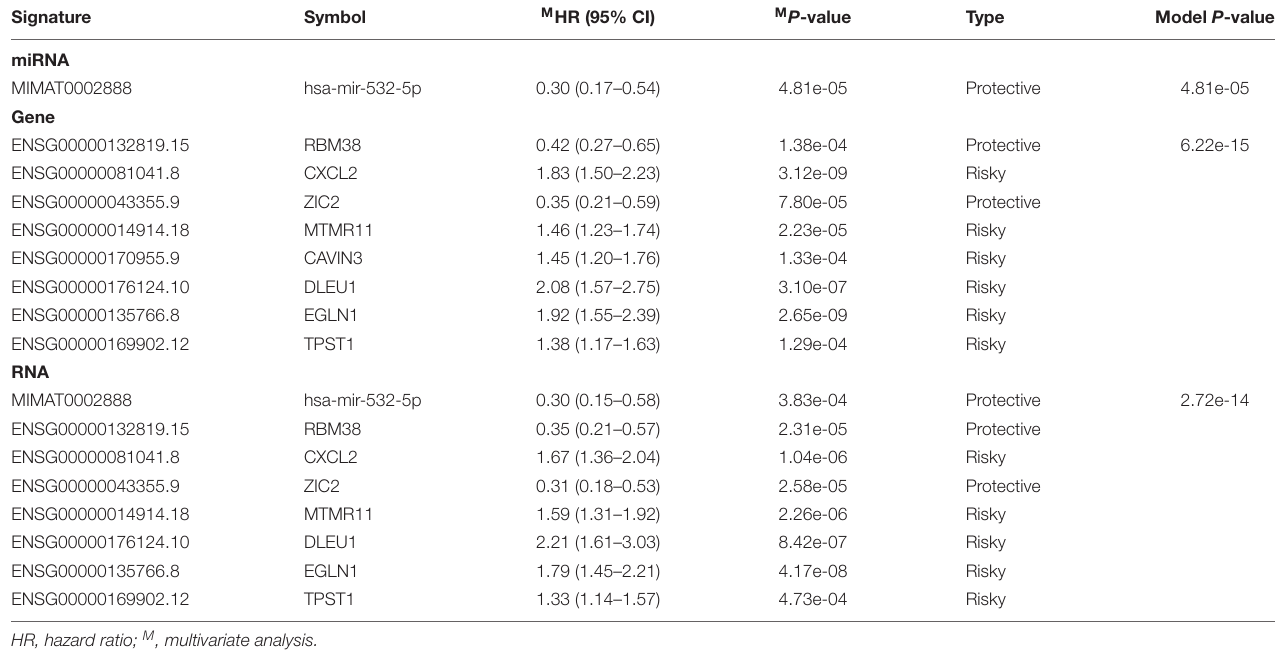
TABLE 2 | miRNA signature, gene signature, and transcriptomic